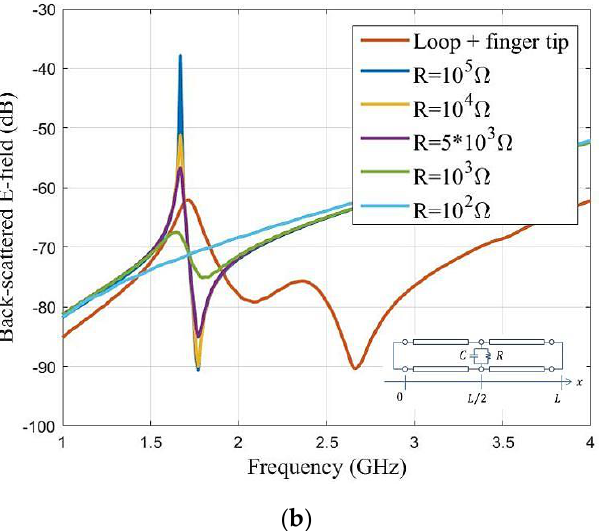
Figure 9. Comparison of backscattered E-field from the loop scatterer at different scenarios. ( a ) Capacitive effect in relation with Figure 8, ( b ) Parametric study on the introduction of a resistor R in parallel to consider the attenuation effect due to the presence of the finger.